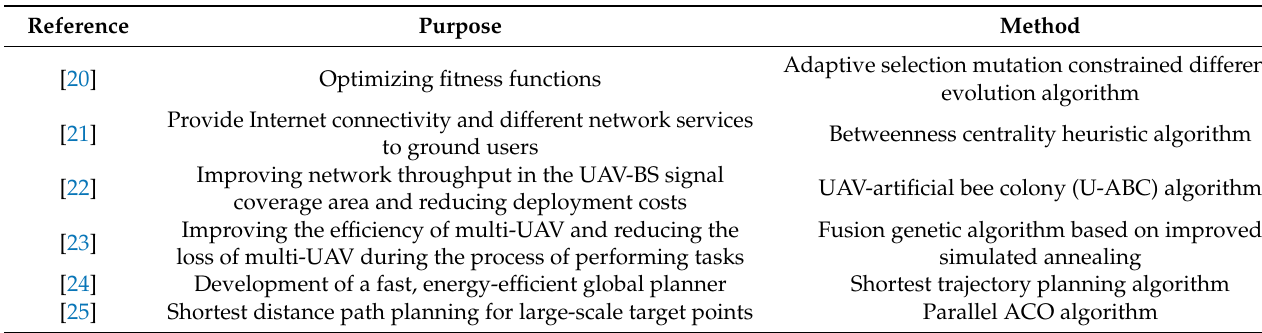
Table 1. UAV path planning